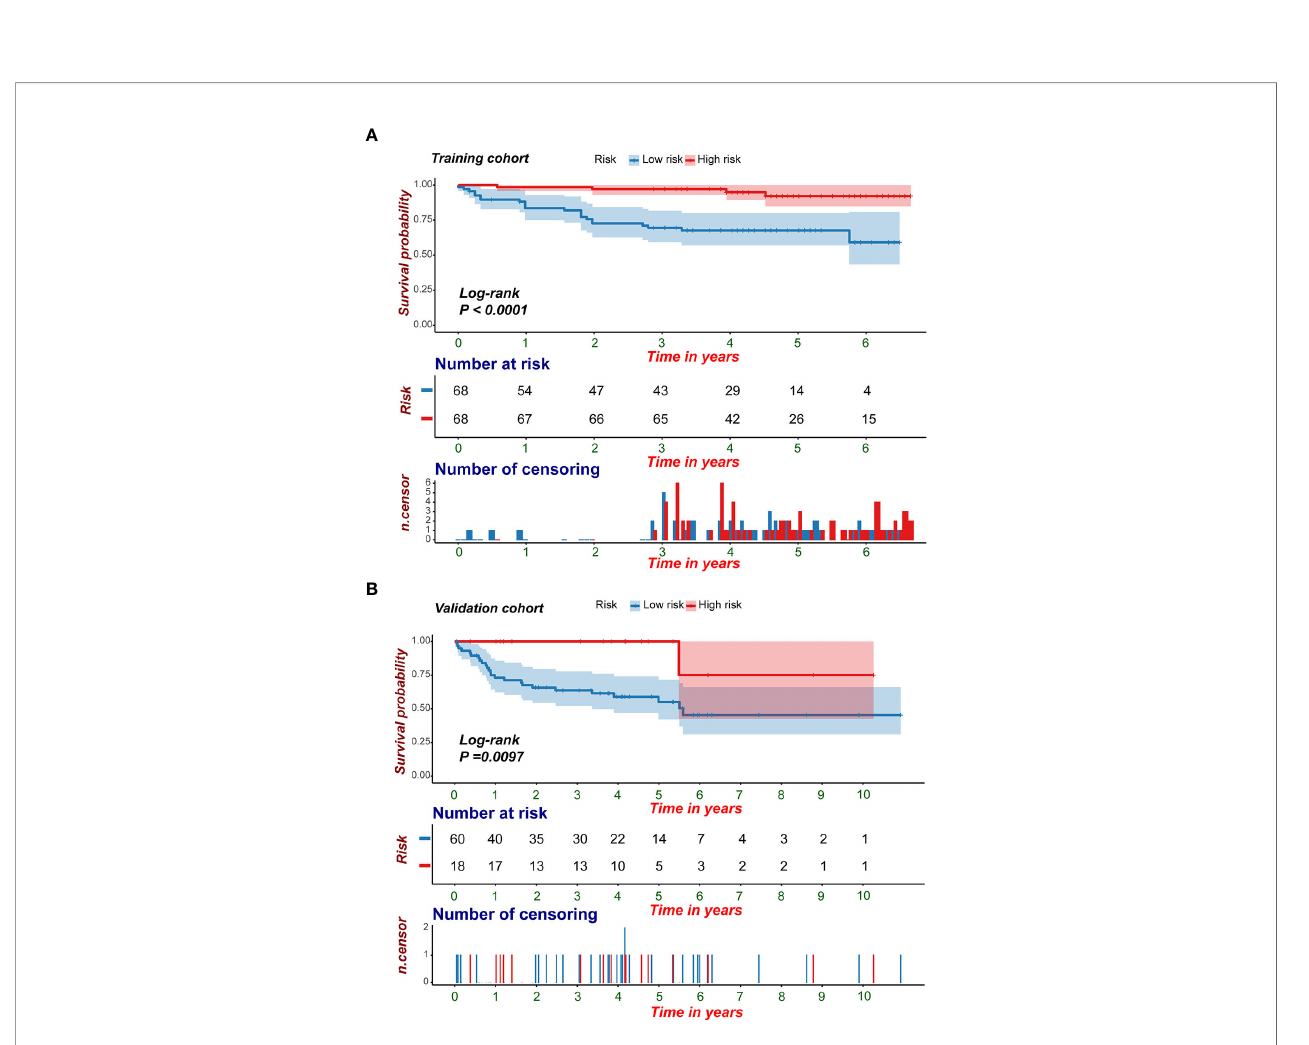
FIGURE 8 | KM survival analyses of the predictive nomogram. (A, B) KM analysis of the predictive nomogram indicated that the high-risk group had a shorter PFI compared with that of the low-risk group. KM, Kaplan-Meier; PFI, progression-free interval